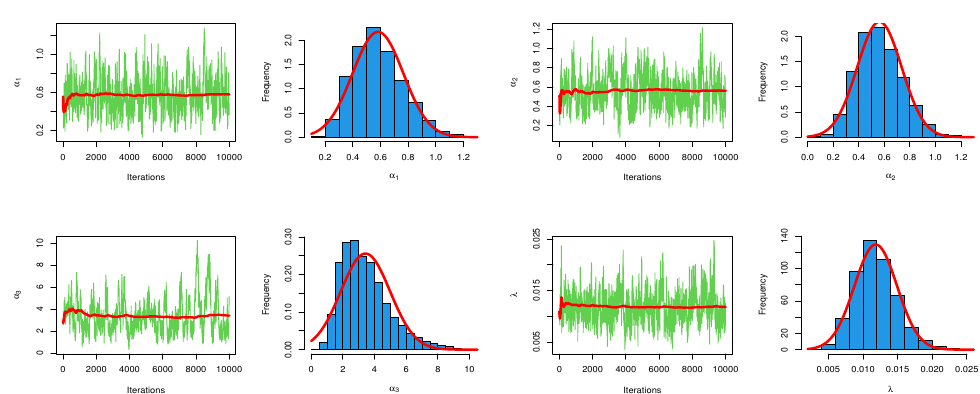
Figure 10. Convergence plots of MCMC for parameter estimates of the EED for censored sample.